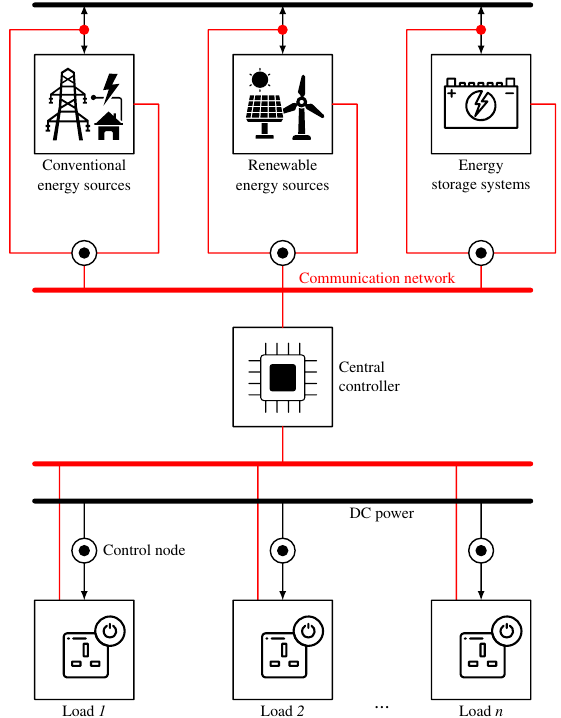
Figure 6. Hybrid central nanogrid controller.